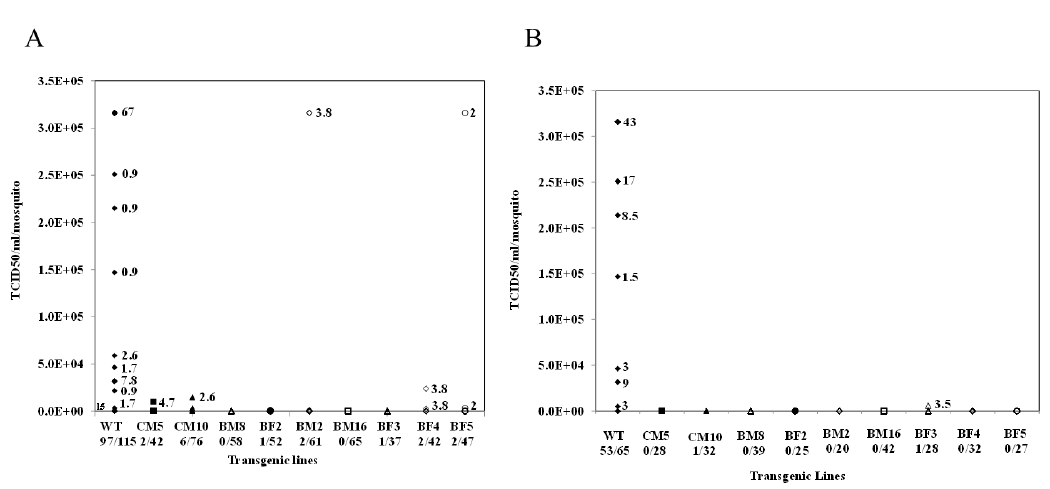
Figure 7. TCID 50 -IFA performed on CHIKV challenged transgenic mosquito lines. ( A ) Results of TCID 50 -IFA performed on partially heterozygous G 6 compared to non-transgenic HWE controls (WT). ( B ) Results of TCID 50 -IFA performed on individual blood-fed heterozygous female mosquitoes of the G 9 compared with Higgs White Eye (HWE) (WT) controls. All titrations were at seven days post blood meal. The percentage of mosquitoes exhibiting a particular viral titer is presented in the graph. The actual number of infected mosquitoes along with the total number of blood-fed female mosquitoes analyzed for each line and the WT control are presented below each X-axis designation.